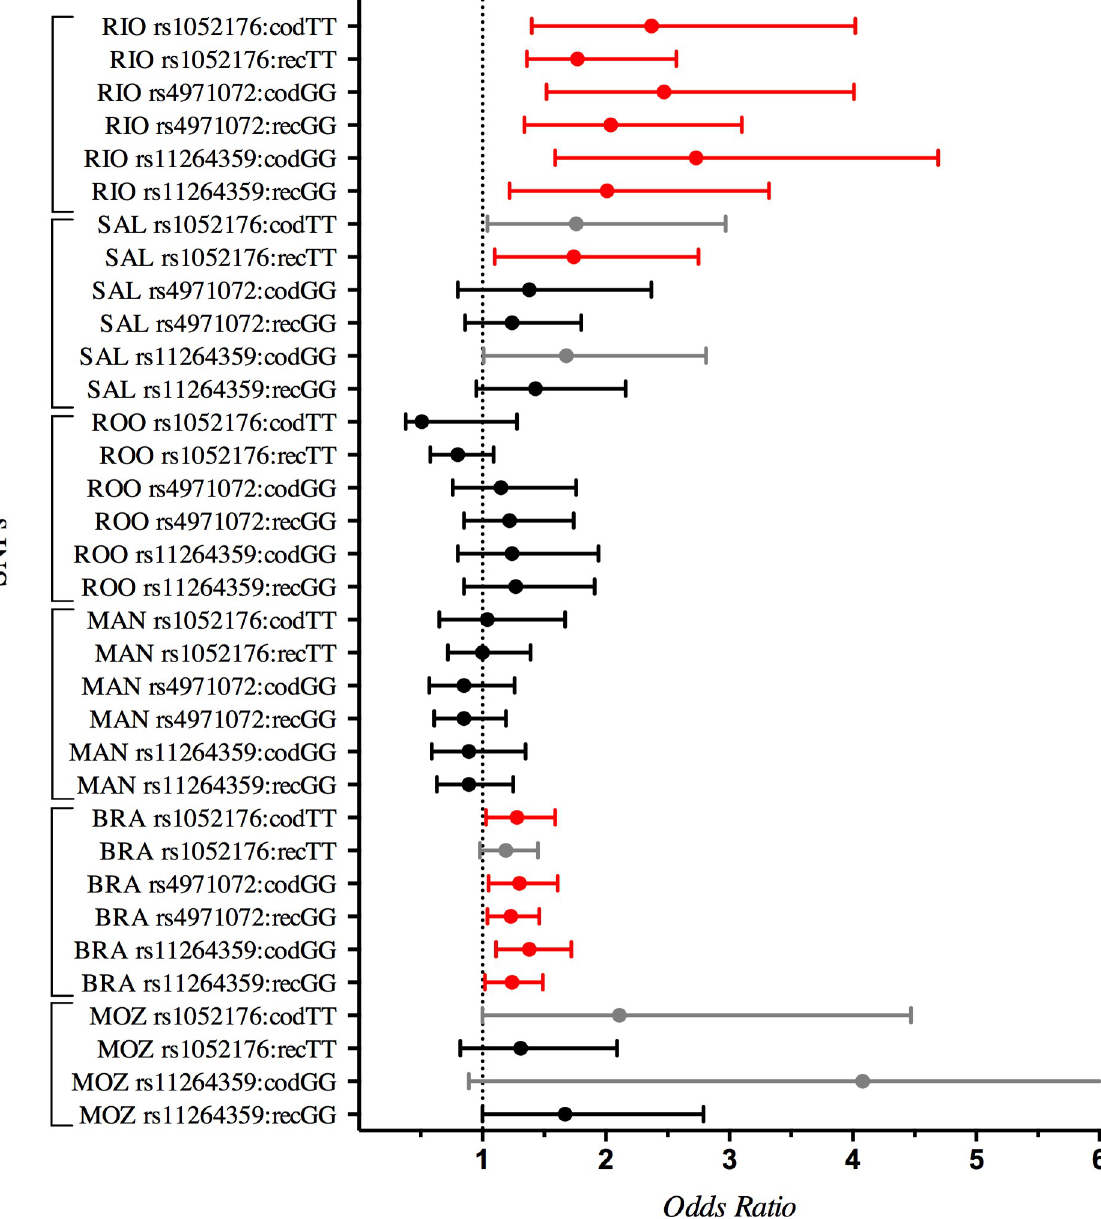
Fig 1. Genetic association of the PKLR SNPs with mycobacterial diseases in the studied population. Only the homozygous genotypes for the association, considered as “risk genotypes”, for the co-dominant (cod) and recessive (rec) models were represented for visualization purposes. The complete data of the individual SNPs are detailed in S3 Table. X-axis shows the Odds Ratio (OR) given in a linear scale. Red and gray dots with 95% confidence interval (CI) represented the significant (p < 0.05) and borderline (0.05 � p � 0.07) associations, respectively. Black dots with 95% CI represented no association. RIO = Rio de Janeiro (Southeast Brazil); SAL = Salvador (Northeast Brazil); ROO = Rondono´polis (Midwest Brazil); MAN = Manaus (North Brazil); BRA = all Brazilians (meta-analysis) and MOZ = Mozambique (East